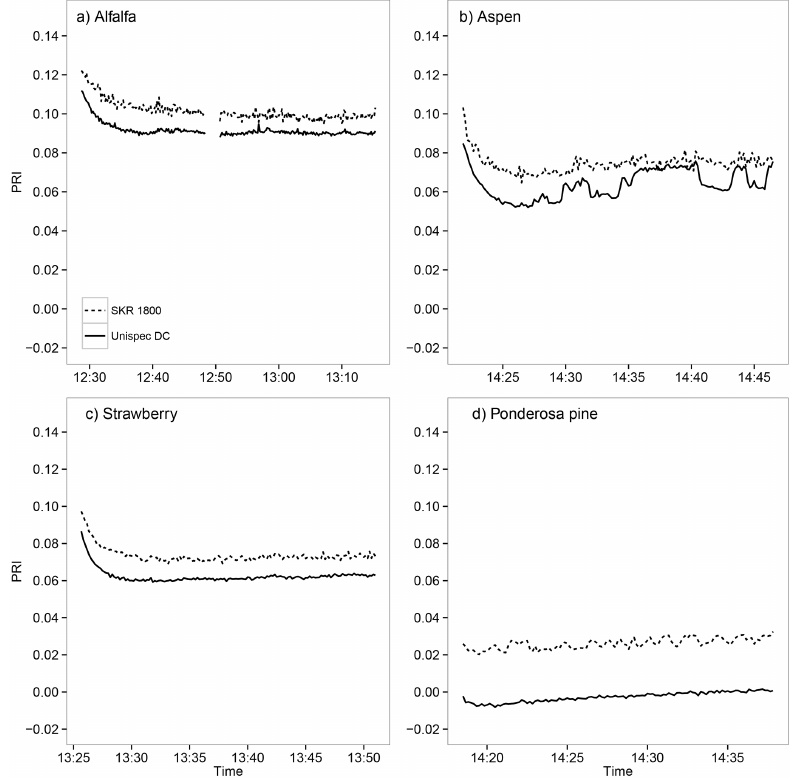
Figure 5. Photochemical reflectance index (PRI) response to a dark-to-light transition for (a) alfalfa ( Medicago sativa ), (b) aspen ( Populus tremuloides ), (c) strawberry ( Fragaria × ananassa ), and (d) ponderosa pine ( Pinus ponderosa ), as recorded by a UniSpec DC instrument and the SKR 1800 sensor pair. Data shown are those that have been corrected to normalize the SRF differences between